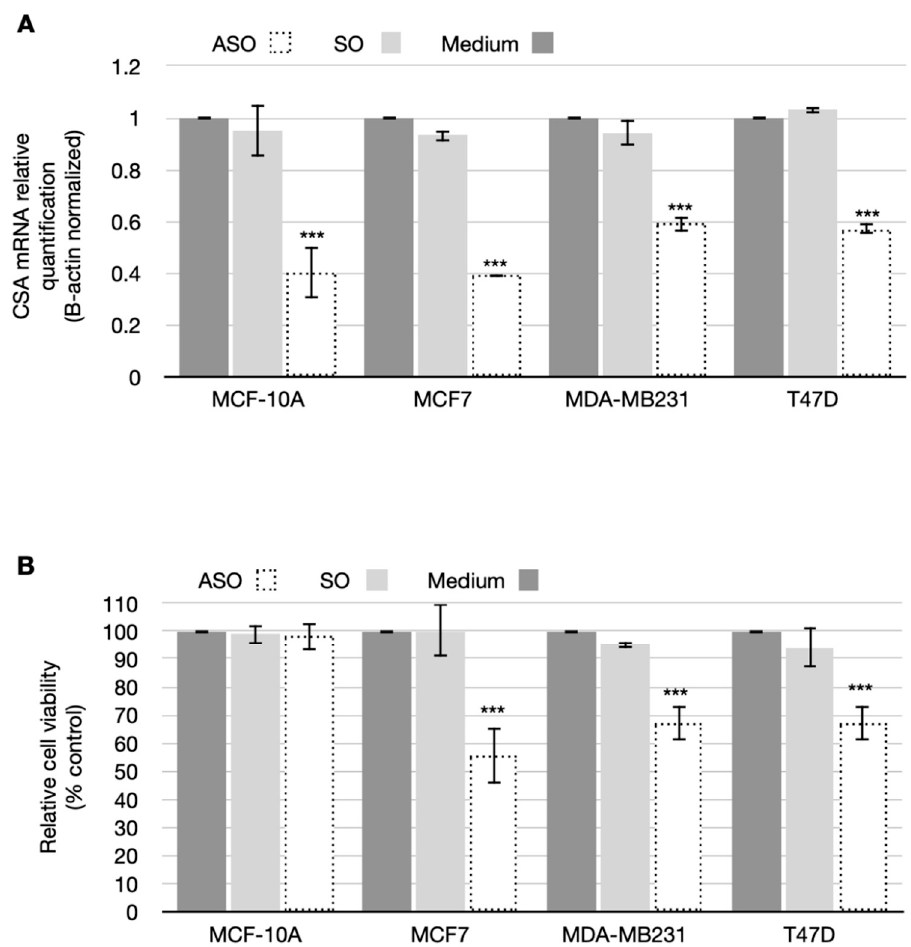
Figure 2. ( A ) qRT-PCR analysis of CSA mRNA expression 24 h after transfection. The results, β -Actin normalized, are presented as means ( ± SD) of three independent experiments. *** is for p < 0.001 calculated with ANOVA test. ( B ) Graph showing relative cell viability obtained by MTT assay after 24 h of transfection. Data are presented as means ± SD of three independent experiments. *** is for p < 0.001 calculated with ANOVA tests.